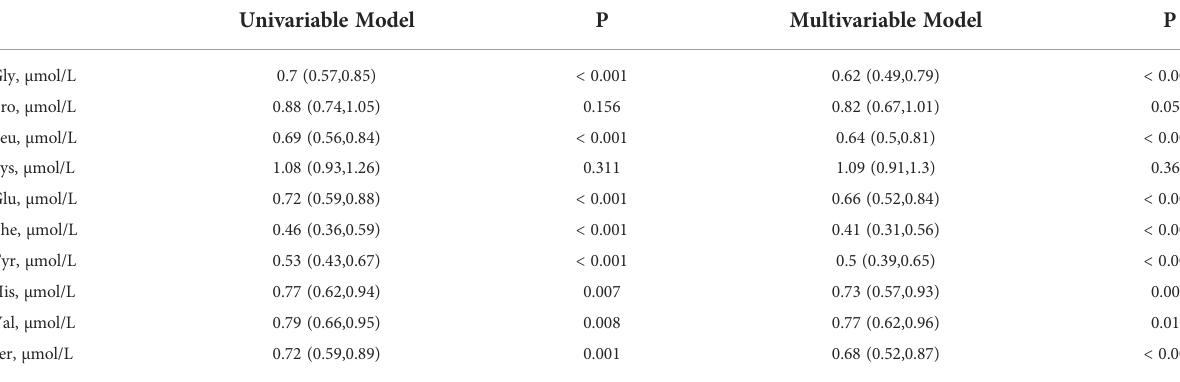
TABLE 2 Logistic regression of different amino acids and DR under the action of